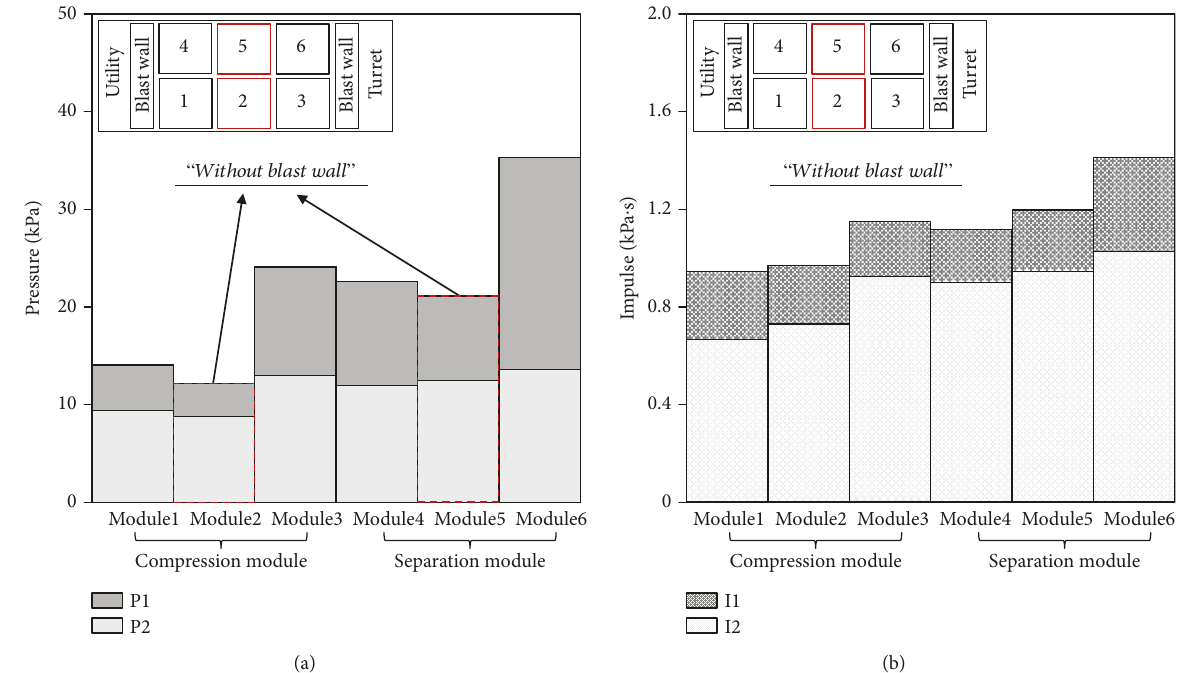
Figure 6: The average peak pressure and impulse in each pressure phase at the modules. (a) Average peak pressure; (b) average